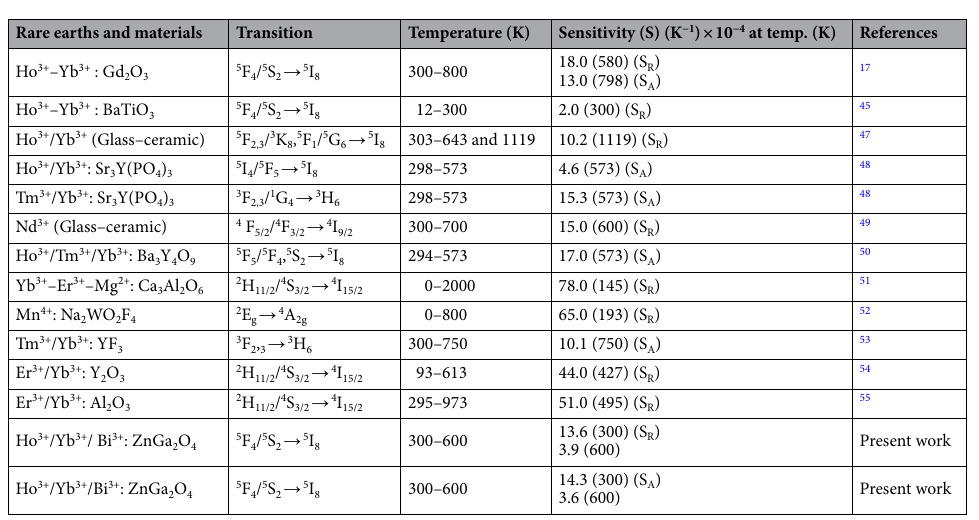
Table 1. Comparative analysis of temperature sensitivity values found in the present case and reported by the other